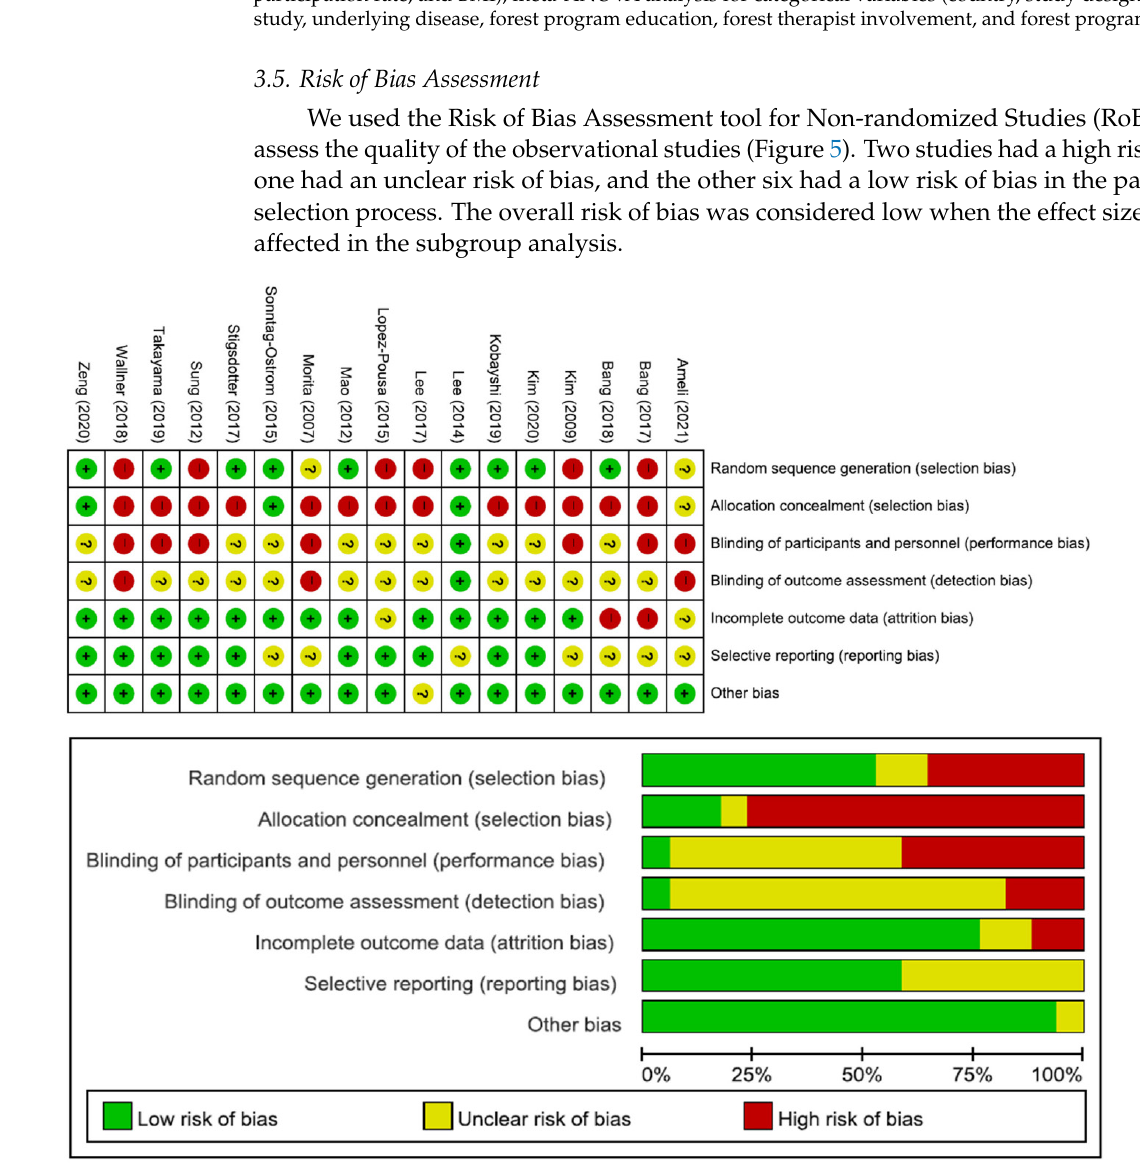
Figure 5. Summary of the risk of bias assessment. Refs are